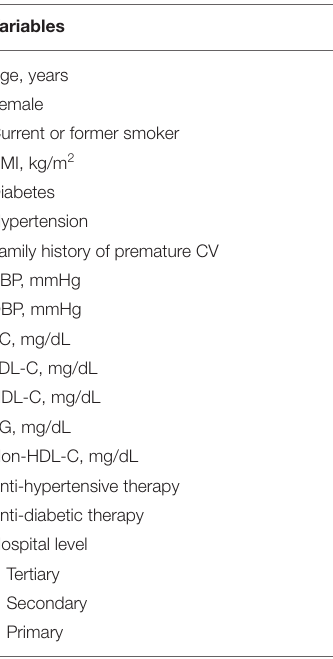
TABLE 2 | Comparison between patients with and without aspirin in low risk group.